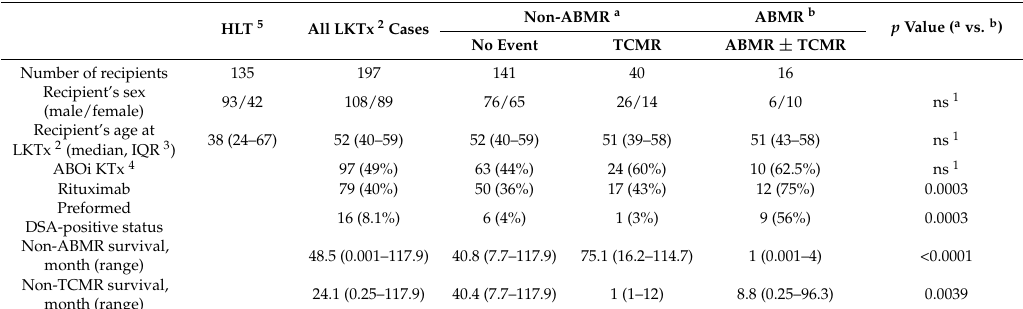
Table 2. Demographics of the patients in each